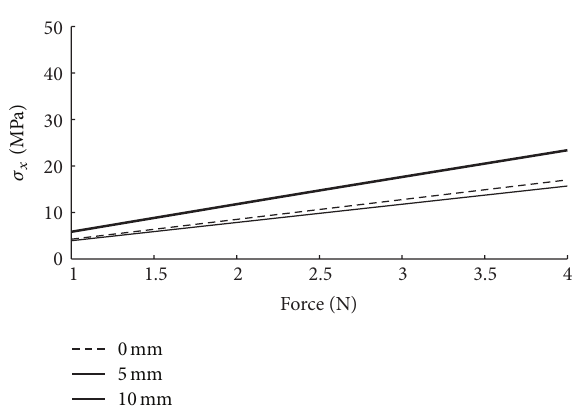
Figure 7: Variation of stress at x -direction for SCR of Model I under the position angle of 34 ∘ .